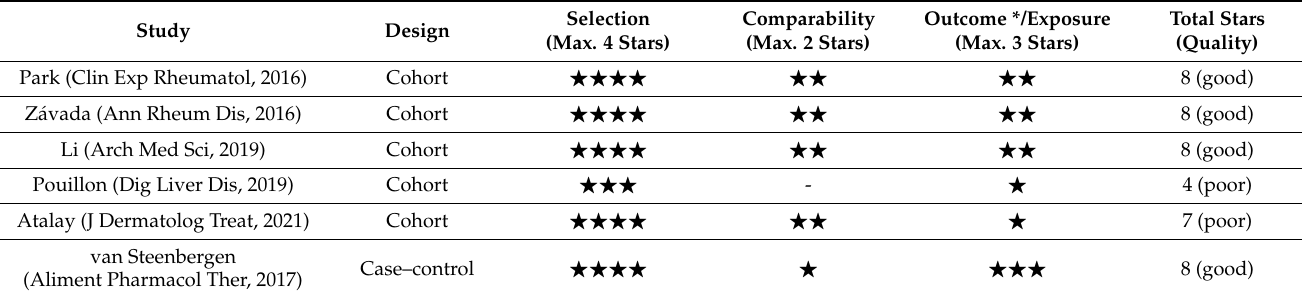
Table 2. Risk of bias of non-RCTs (Newcastle–Ottawa